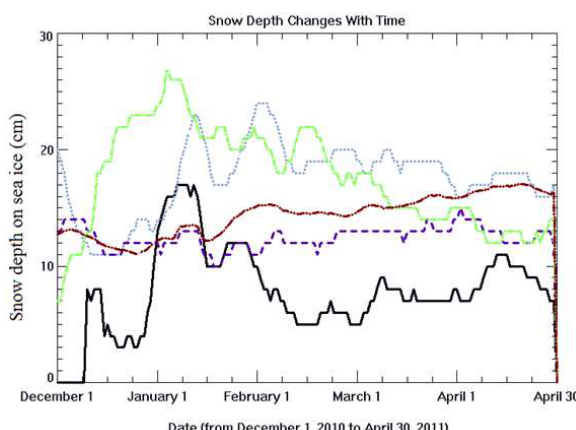
Figure 10. Variations of snow depth at 4 points (black Solid: point 1; dotted: point 2; dashed: point 3; dash dot: point 4; red line: average snow depth of the